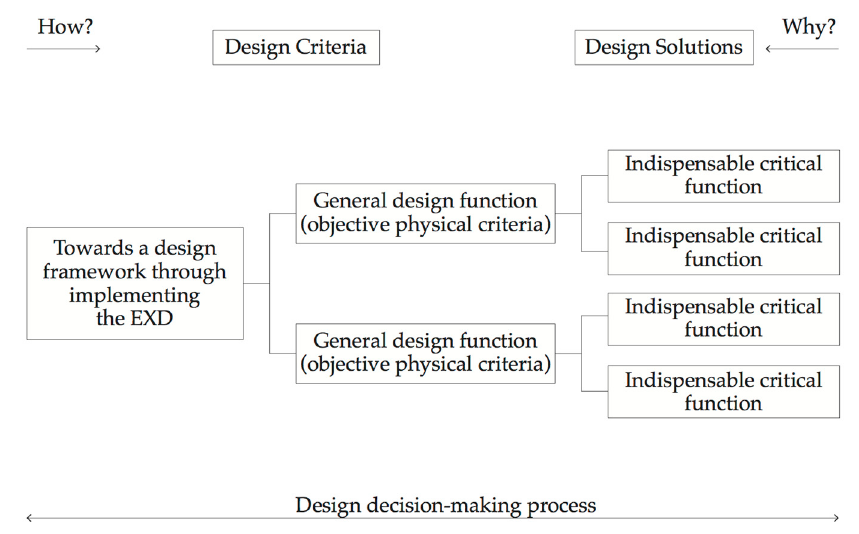
Figure 2. General Function Analysis System Technique (FAST) diagram image.